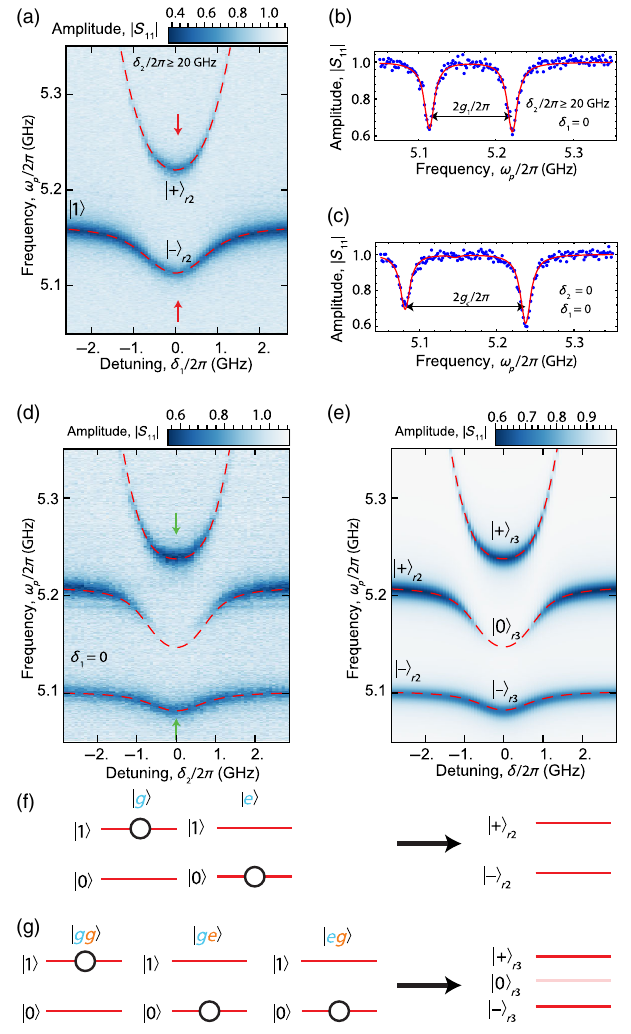
FIG. 2. Individual and two-qubit vacuum Rabi mode splitting. (a) Measured reflection coefficient j S 11 j vs drive frequency ω p and charge detuning δ 1 for DQD 1 ( 2 t 1 = 2 π ¼ 5 . 166 GHz) tuned = 2 π ¼ into resonance with the SQUID array resonator ( ω r 5 . 171 GHz). The red dashed lines are extracted from fits to a master equation model; see the text for details. (b) j S 11 jð ω at p Þ δ 0 [red arrows in (a)]. (c) j S ω at δ 1 ∼ δ 2 ∼ 0 [green 1 ¼ 11 jð p Þ arrows in (d)]. (d) j S 11 j vs drive frequency ω and charge p detuning δ 2 for DQD 1 biased at 2 t 1 = 2 π ¼ 5 . 166 GHz and δ ≈ 0 and DQD 2 t 2 π ¼ 5 . 156 GHz realizing ω 1 2 at 2 = r ¼ ω ω ≈ 0 . (e) Master-equation simulation of at δ 1 ; 2 DQD 1 ¼ DQD 2 j S 11 jð δ 2 ; ω p Þ fitting to the data in (d), details in Appendix C. Schematic energy-level diagram of (f) one and (g) two DQDs interacting with the resonator. Basis states are shown on the left, coupled states on the right; see the text and Appendix C for state